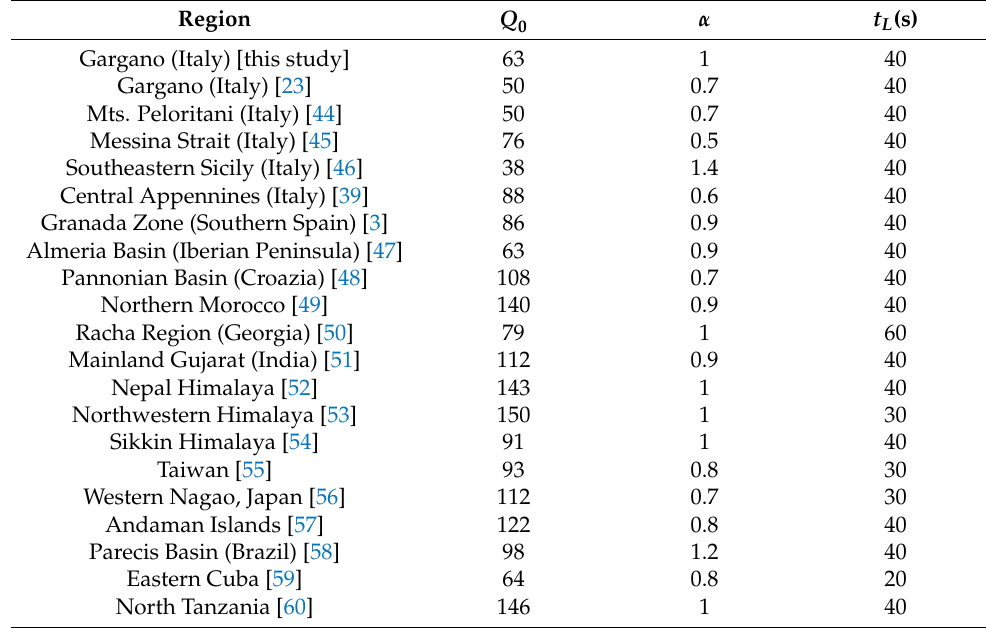
Table 2. Comparison of Q 0 and α of other regions with active tectonics in Italy and worldwide, for approximately the same t L